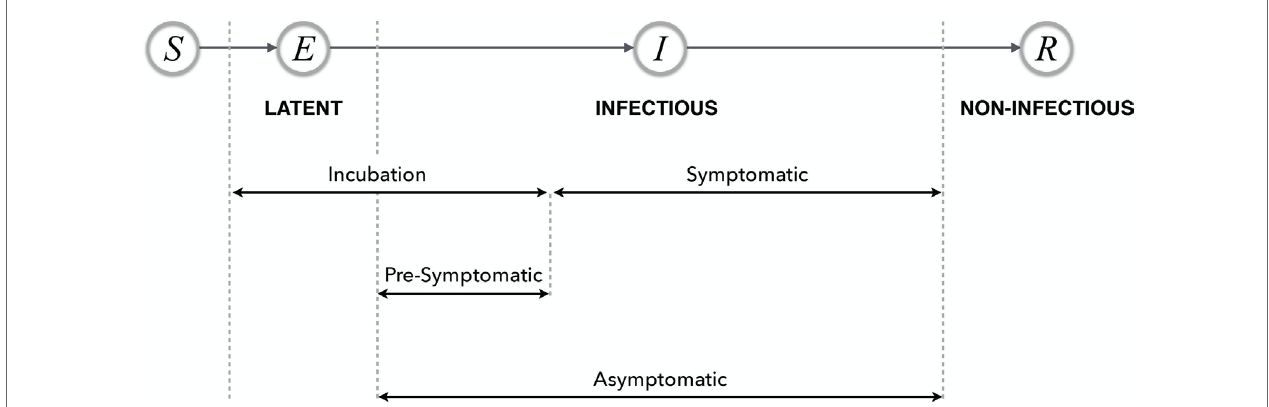
FiGURe 1 | Possible timelines and various stages of disease with their relationship in the SeiR model . The terms latent, infectious, and non-infectious are transmission-related, and the remaining terms are all